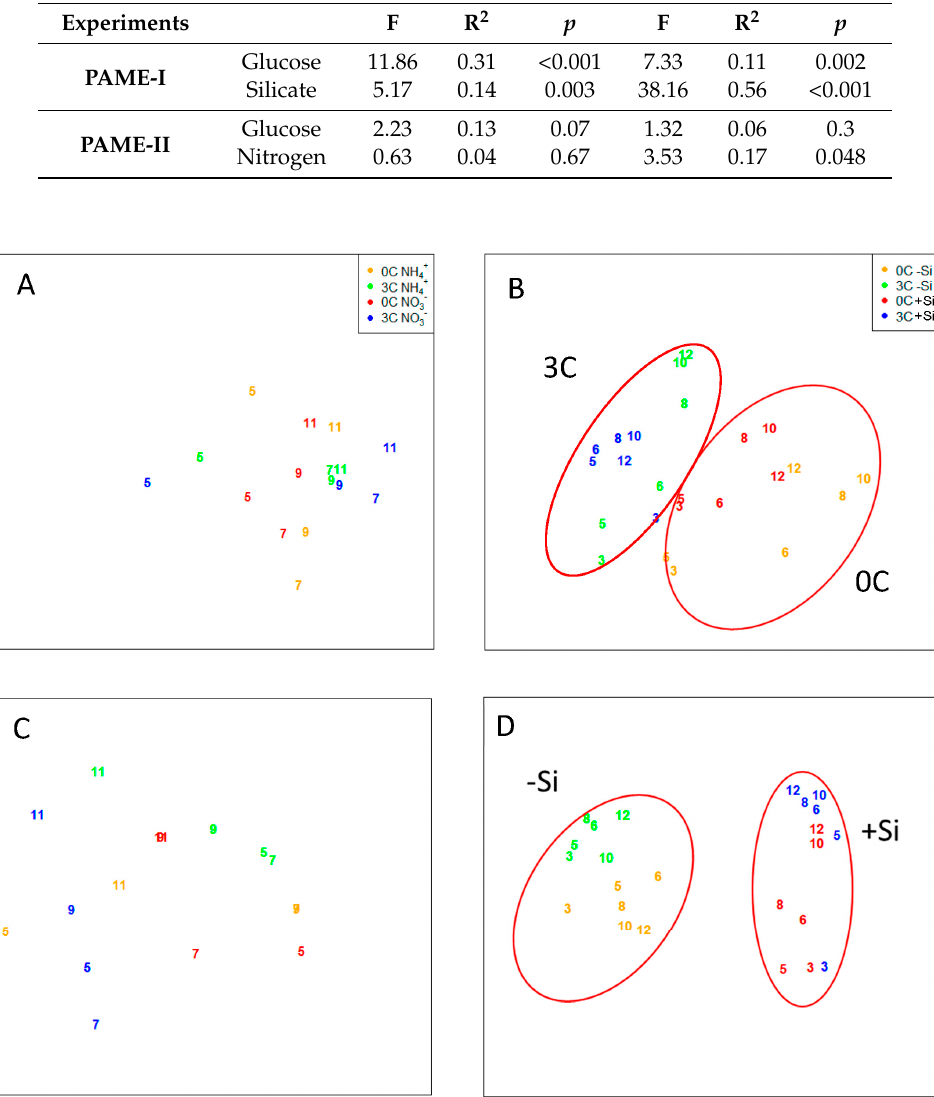
Figure 6. Nonmetric multidimensional scaling analysis (NMDS) based on the band pattern in the DGGE (bacteria ( A , B )) and PFGE (virus ( C , D )) analysis. Binary data for NMDS analysis from PAME-I is redrawn from [15]. See Figure 2 for more information about experimental design.